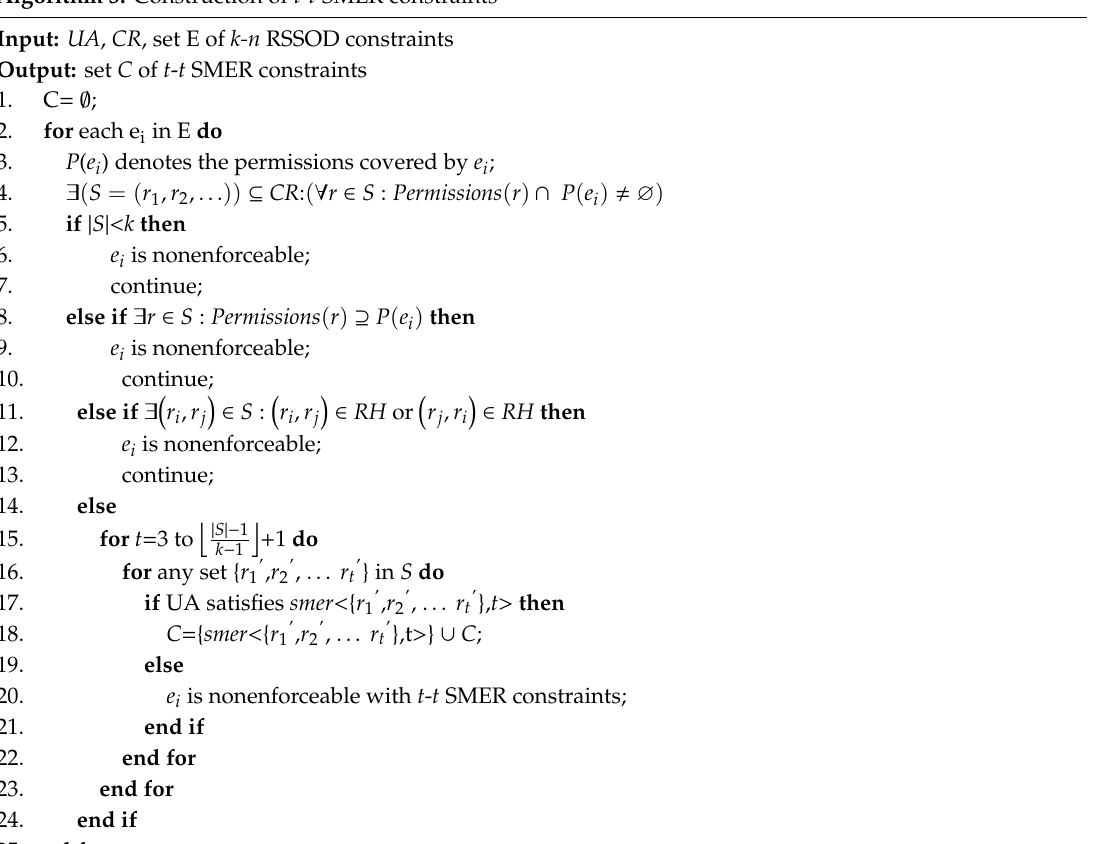
Algorithm 3. Construction of t - t SMER